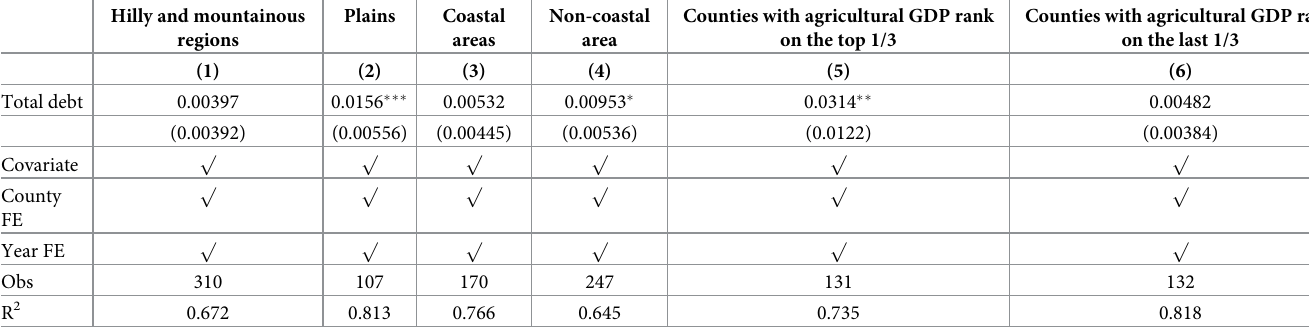
Table 8. Heterogeneity analysis of influence of village debt and land transfer. Hilly and mountainous